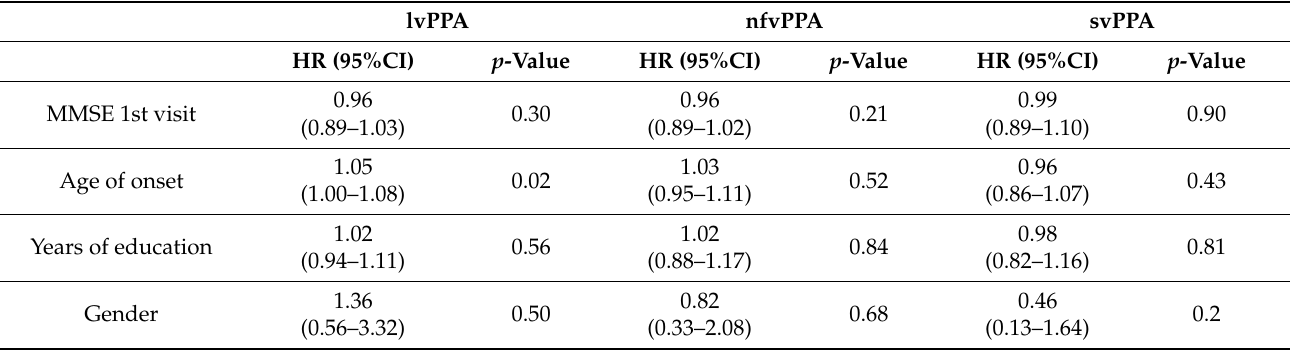
Table 3. Hazard ratios since onset.